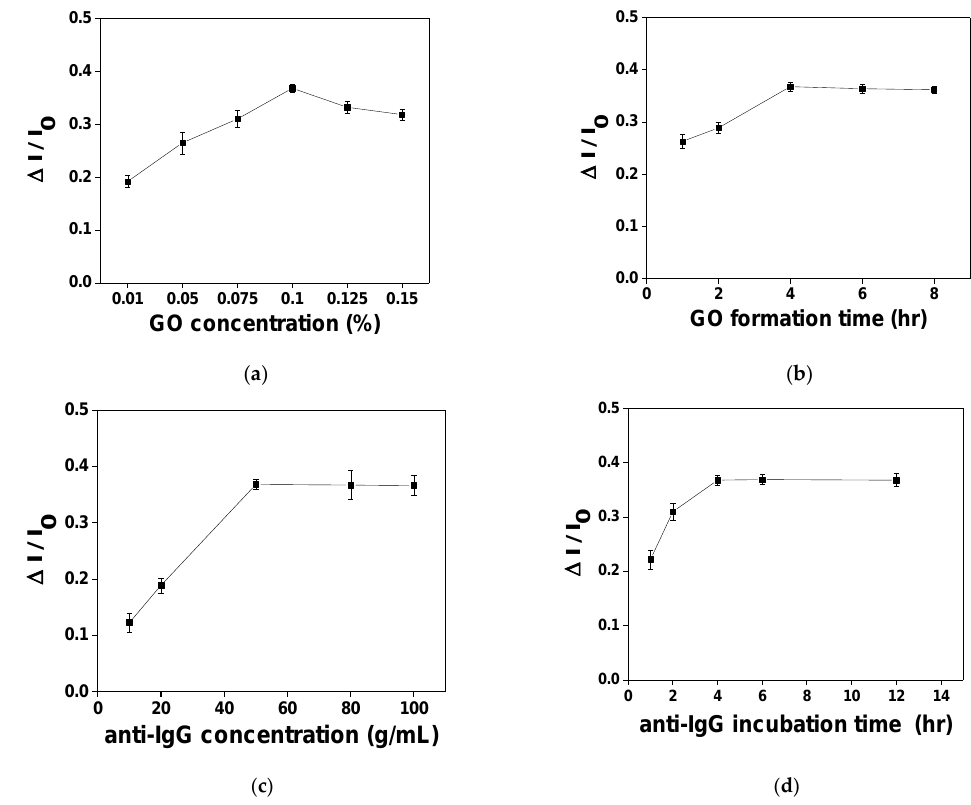
Figure 5. ( a ) Effect of GO concentration ratio in the starting solution on the sensor response. ( b ) Effect of immersion time given to form GO on the sensor response. ( c ) Effect of concentration of anti-IgG used for the bioconjugation process on the sensor response. ( d ) Effect of incubation time of anti-IgG used for the bioconjugation process on the sensor response (n = 3).